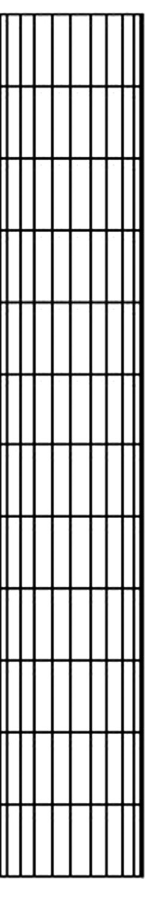
Figure 6: Typical model of the column.